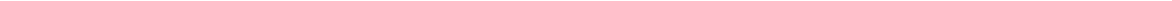
Fig. 2 Transcriptome-wide analysis of 3 ′ -UTR regions identi fi es thousands of stable cleaved tails. a We used three experimental methods to measure separated body and tail RNA fragments at a transcriptome-wide scale; poly(A) selected RNA from U2OS cells was enriched for 5 ′ -capped bodies using TEX treatment (TEX) or anti-Cap immunoprecipitation (CAP IP); uncapped tails were enriched by streptavidin bead pulldown of in vitro